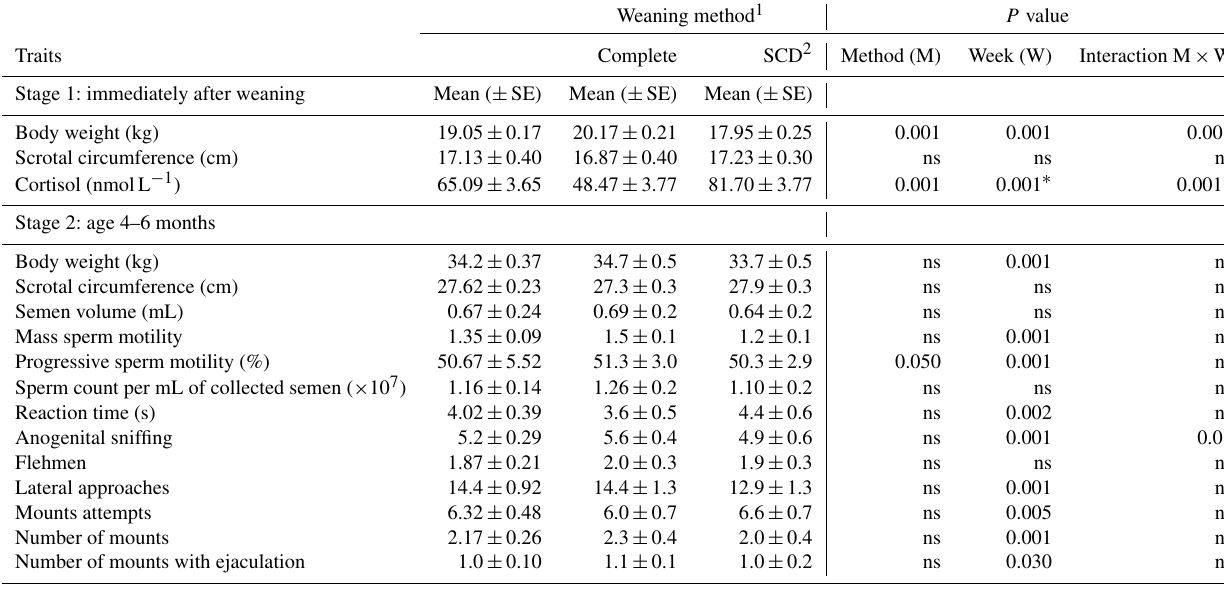
Table 1. Effects of weaning method and time of measure on cortisol levels after weaning, scrotal circumference and growth, and sexual behavior traits of Saint Croix